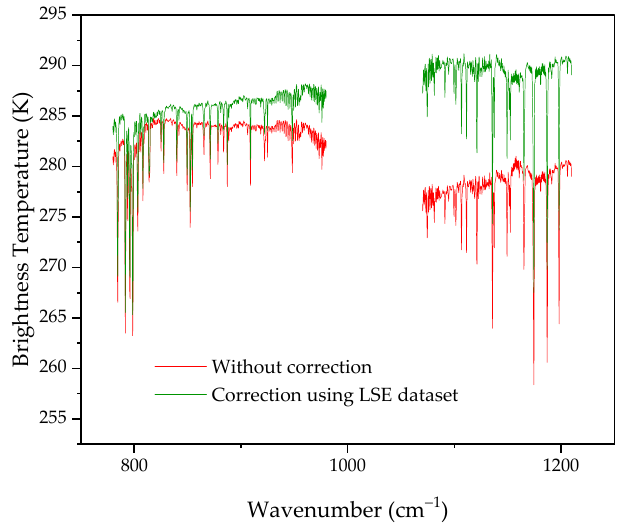
Figure 4. Brightness temperature desert spectrum example before and after the LSE correction using a monthly average emissivity value (Adapted with permission from Ref. [44], 2021, Daniel Zhou).